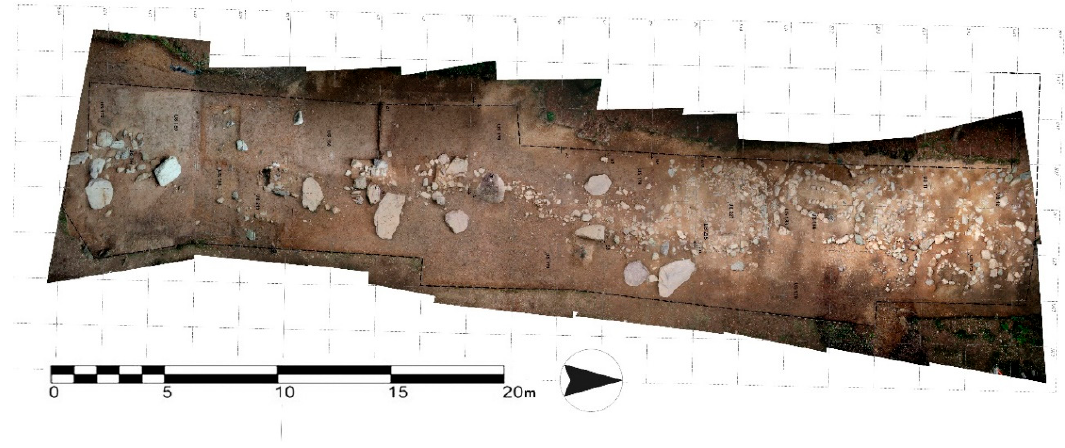
Figure 2. Ortophotograph of the Ossimo-Pat site.